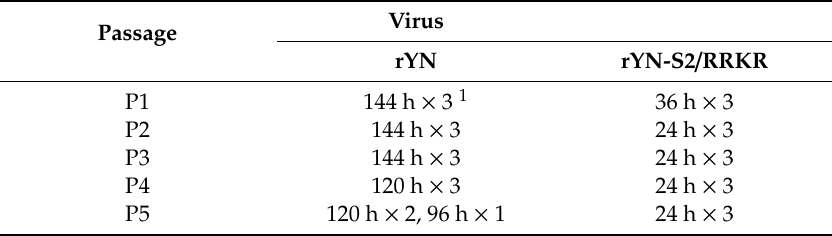
Table 1. Time of death of embryonated eggs inoculated with rYN or rYN-S2 /